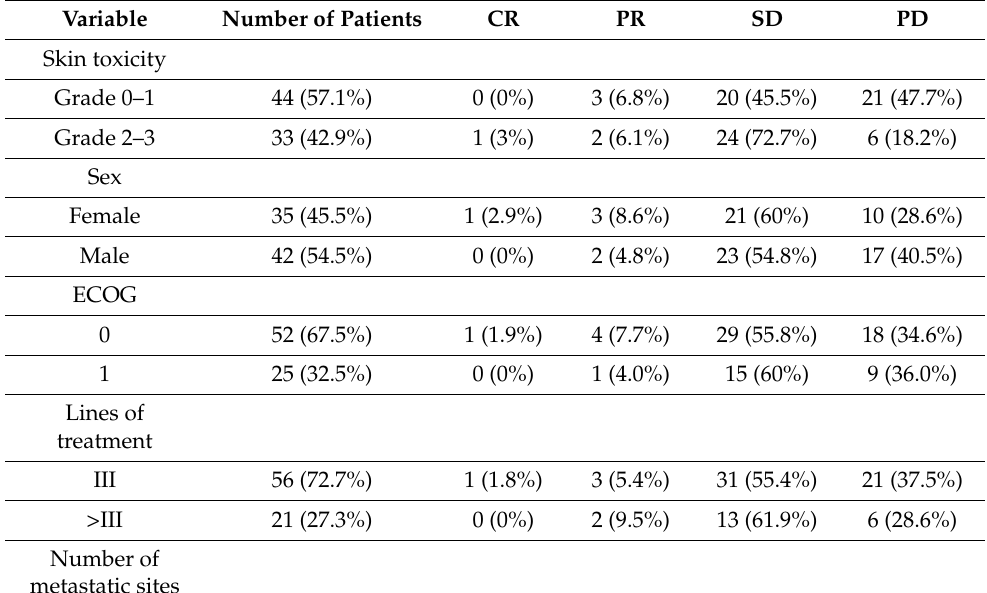
Table 3. Association of clinical variables with overall response